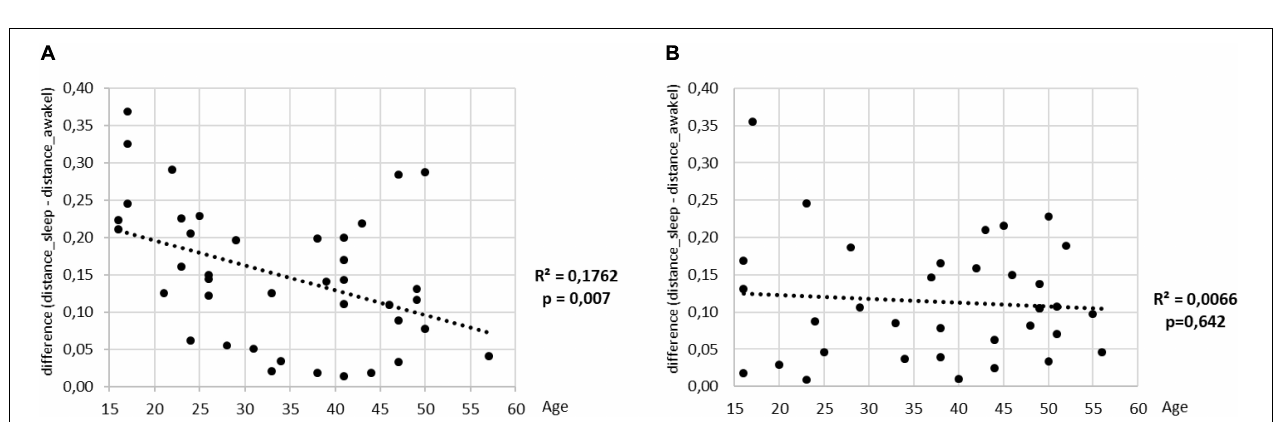
FIGURE 12 | (A) Scatter plot of self-reported time of falling asleep (shown horizontally) vs. time of falling asleep calculated via best shapelet as described in the text (shown vertically) for male subjects. Each subject is shown as one point. The diagonal is marked for easier orientation. For simplicity and easier comparison, we took only subjects who fell asleep between 19:00 and 00:00. (B) The same for female subjects.